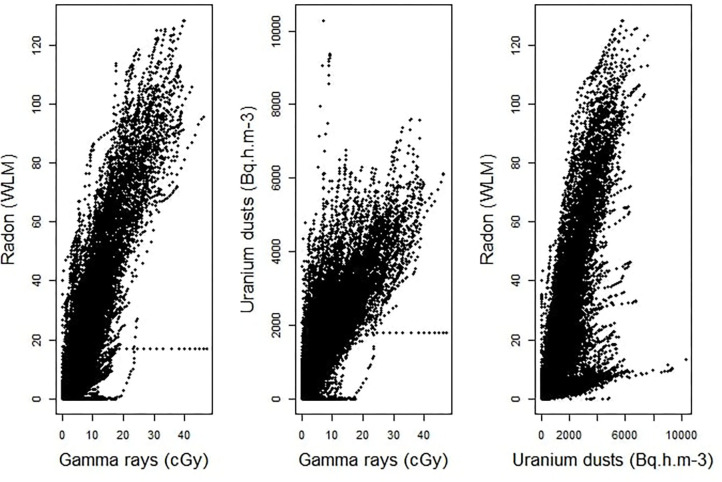
Scatter plots of the observed cumulative exposures to γ-rays and radon (left-hand panel), γ-rays and uranium dust (at the center), radon and uranium dust (right-hand panel).